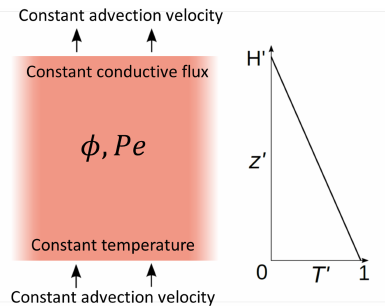
Figure 1. Initial and boundary conditions.